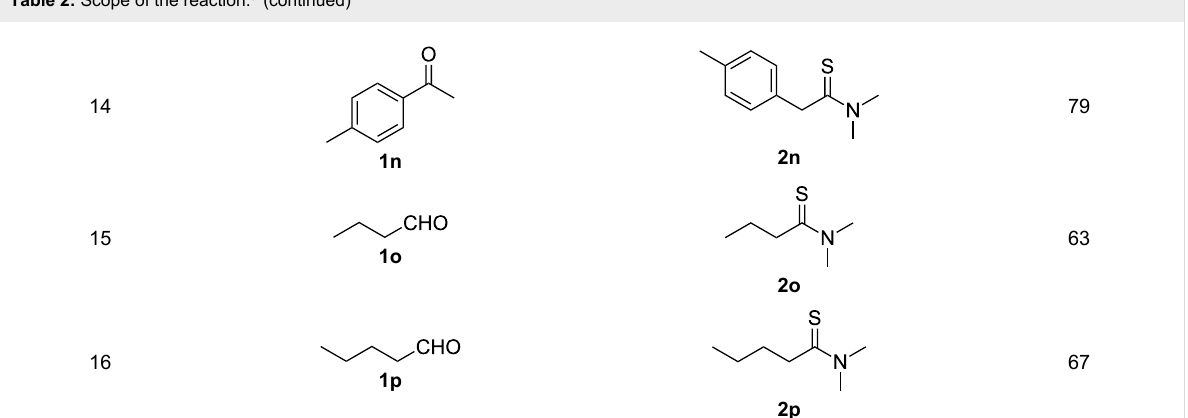
Table 2: Scope of the reaction. a (continued)